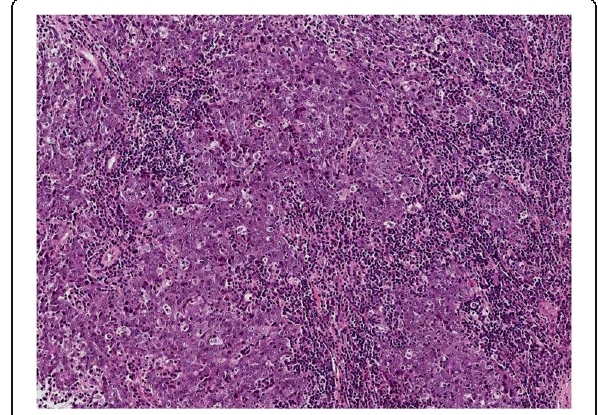
Fig. 2 Histopathology picture of nasopharyngeal carcinoma showing invasive cords and nests of oval to cuboidal cells with large hyperchromatic and mitotically active nuclei